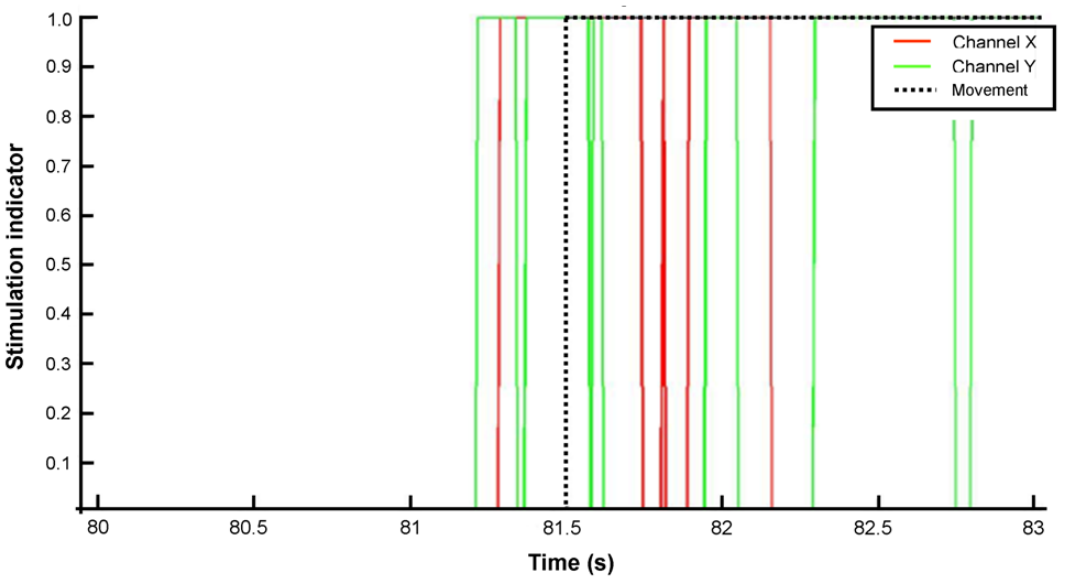
Figure 6. Prediction of the movement on the basis of the kinematic module (see also Figure 2). Red and green lines represent the predictions from the x-axis and y-axis, respectively. The black vertical dotted line corresponds to the voluntary movement. In this case, the movement is predicted approximately 250 ms in advance with the y-axis of the gyroscope